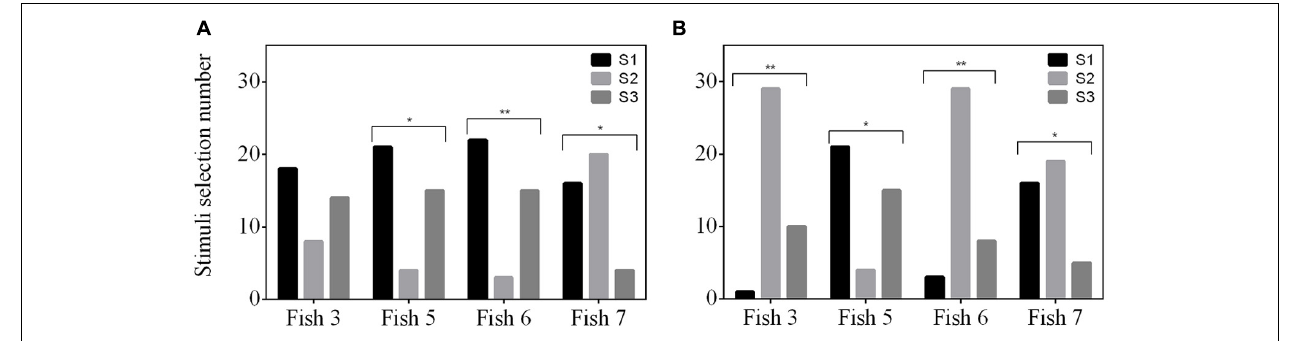
FIGURE 4 | Selection frequency of three stimuli (S1, S2, and S3) for two experiments; (A) delayed MTS/ OFS, and (B) simultaneous MTS/OFS. See Table 1 for example stimuli. The total trial number